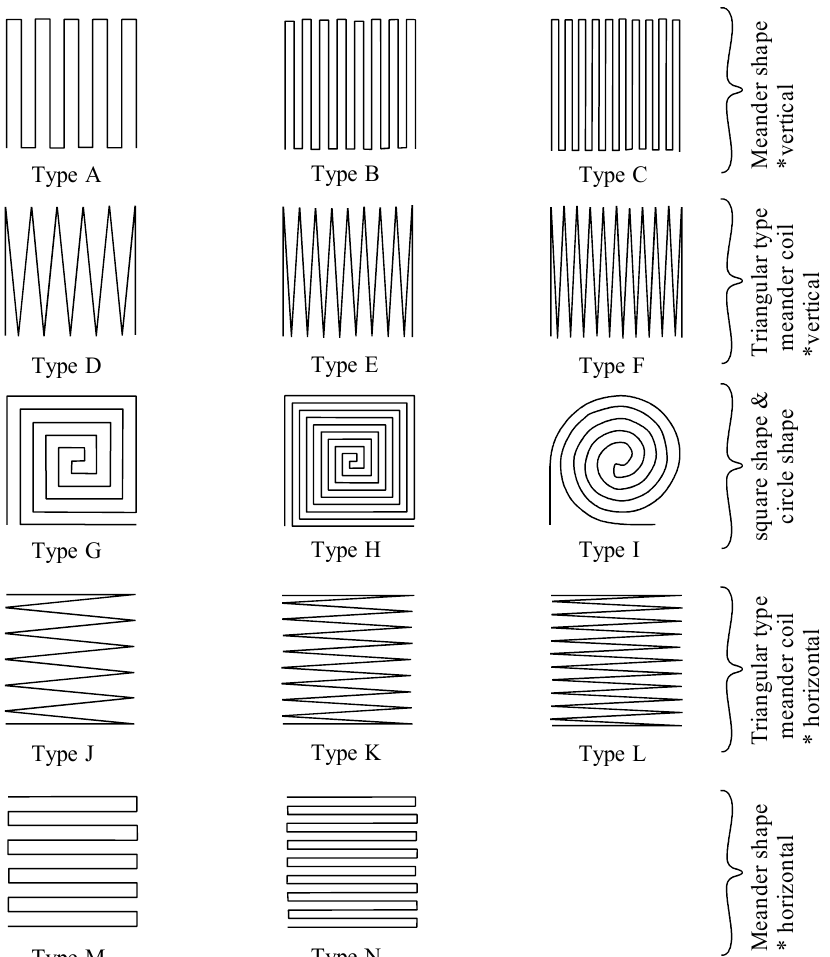
Figure 3. Various inductive coil